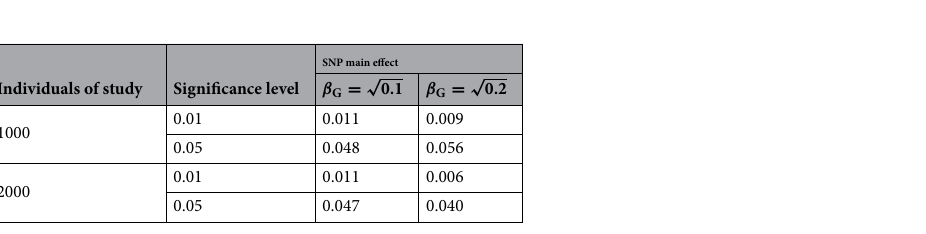
Table 2. The values of type I error rates at different scenarios for the test of SNP-environment interaction with 40% overlapping data.